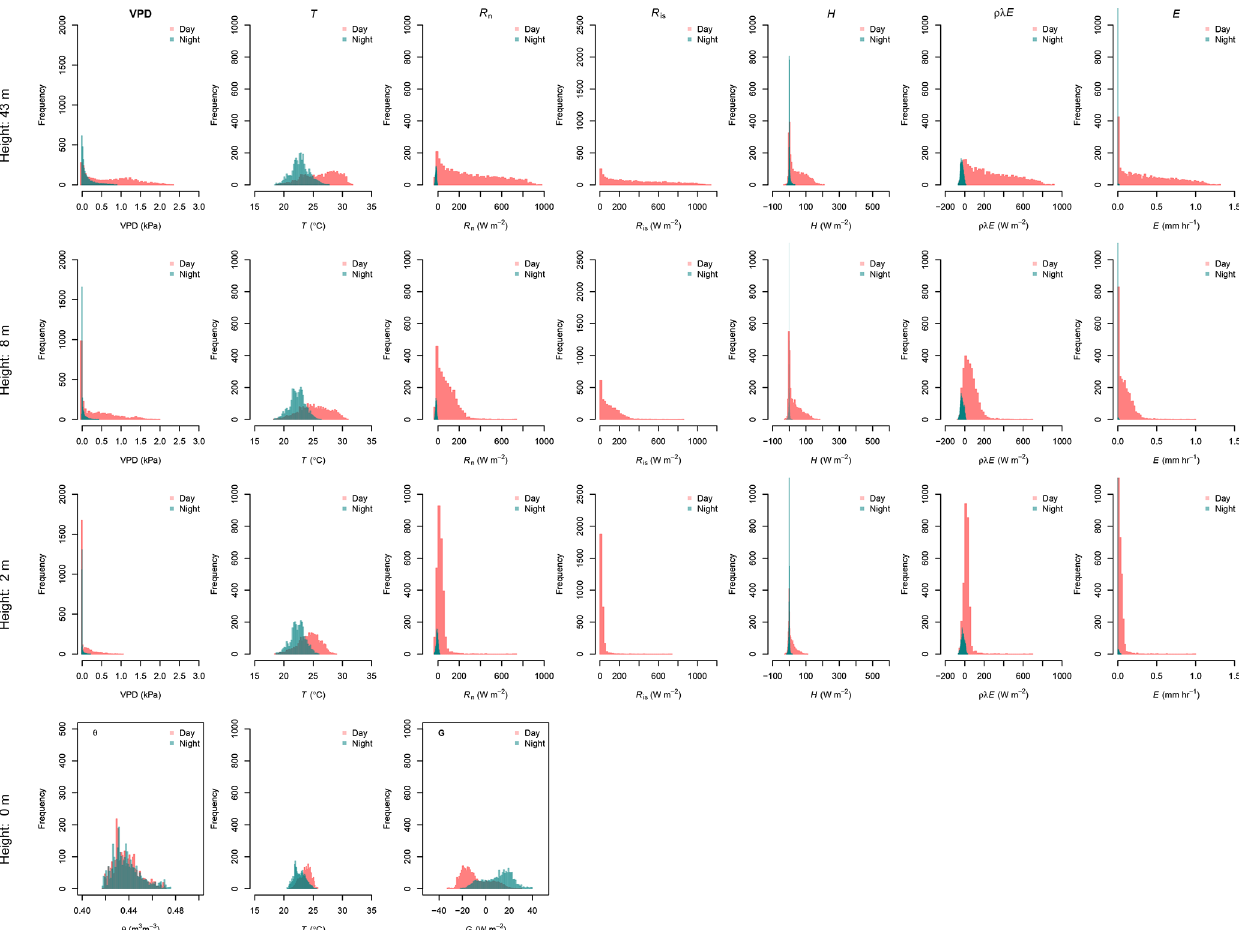
Figure 4. Histograms of the data collected during 62d of monitoring along the canopy profile of the forest. The variables vapor pressure deficit (VPD), soil moisture ( θ ), and air and soil temperature ( T ), as well as the energy fluxes ( R n , G , R is , H , λρE ) and evaporation ( E ) at 43, 8, 2 and 0m height are compared during day- and nighttime. Daytime is defined as the period between 06:00 and 18:00LT and nighttime between 18:00 and 06:00LT. Negative values of λρE were considered as 0mmh − 1 of E